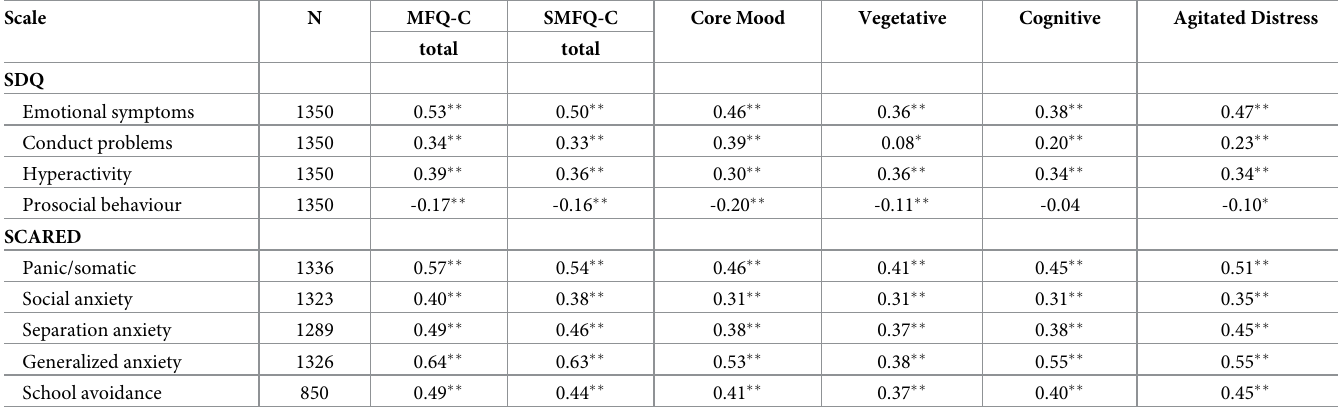
Table 4. Spearman’s correlations between the Mood and Feelings Questionnaire scales and subscales and similar psychometric scales.